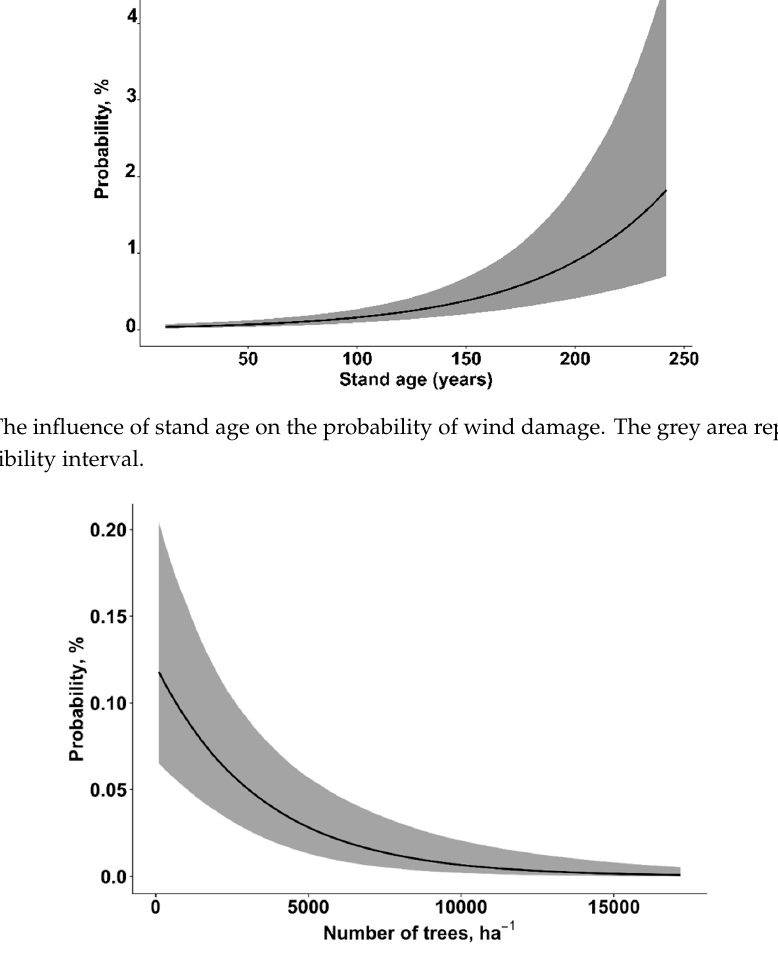
Figure 2. The influence of stand density (trees ha − 1 ) on the probability of wind damage. The grey area represents the ±95% credibility interval.